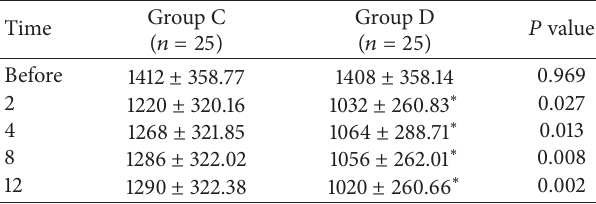
Table 3: Ibuprofen (NSAID) consumption (mg/week).